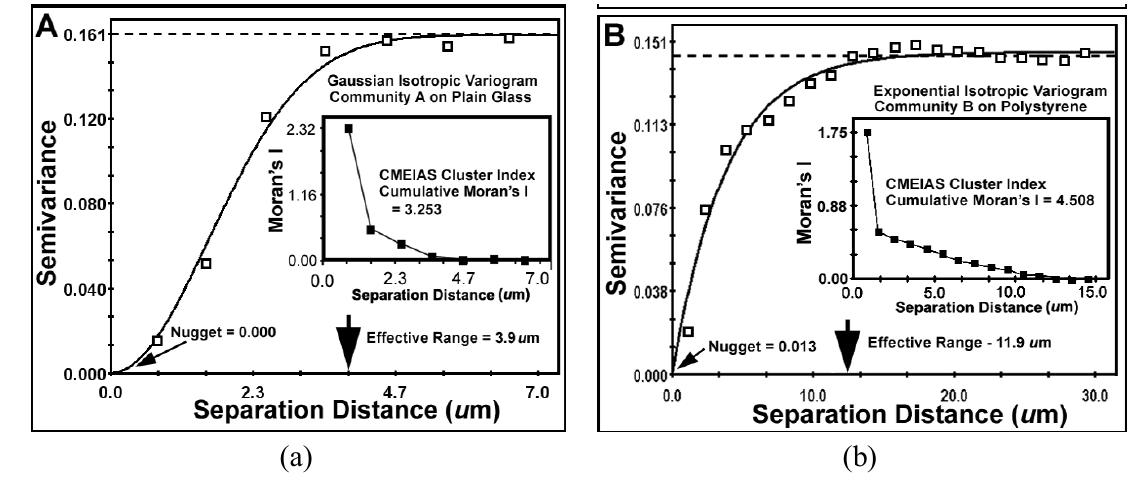
Figure 10. Variogram plots of the spatially autocorrelated Z-variate of Cluster Index for all bacteria in the biofilm landscapes of communities A (a) and B (b) . Shown are differences in (1) sample variance (dashed lines), (2) the mathematical model best fitted to the data (solid lines and its associated statistics), (3) the effective ranges of separation distance (large arrows at the X axis), (4) the nuggets (small arrows at the Y axis) and (5) the Moran’s Index insert plot of positively autocorrelated Z-variate